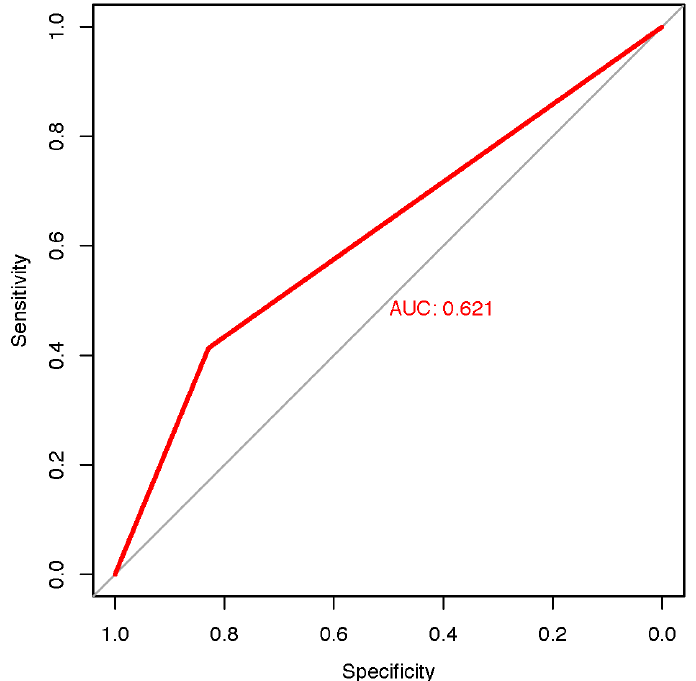
Figure 3. Receiver operating characteristic curve of the smartphone app in relation to the results of the combination of risk assessments by dermatologists, FotoFinder ATBM ® , and Vectra ® WB360 (sensitivity: 41.3%, specificity: 82.9%); AUC = area under the curve.